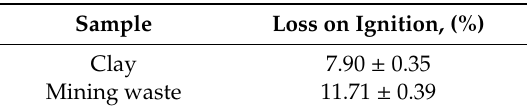
Table 3. Loss on ignition of clay and mining